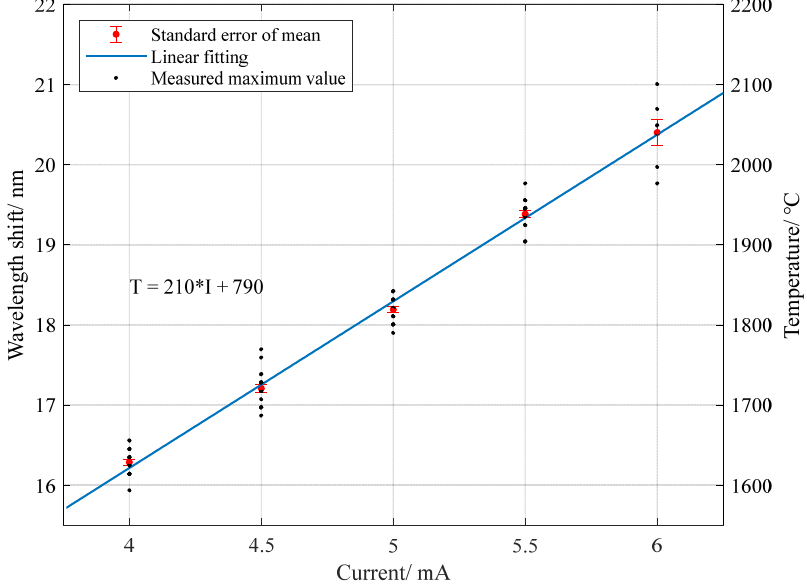
Figure 4. Relationship between wavelength shift (temperature) and applied discharge currents.